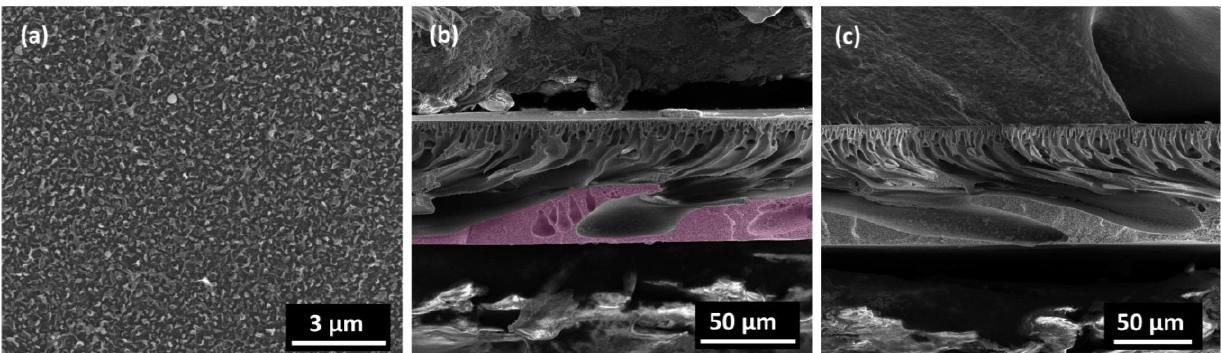
Figure 5. ( a ) SEM images of the TFC FO membrane active layer; ( b ) Zn 2 GeO 4 /PES; ( c ) PES membrane cross section. The highlighted section indicates the thick pore